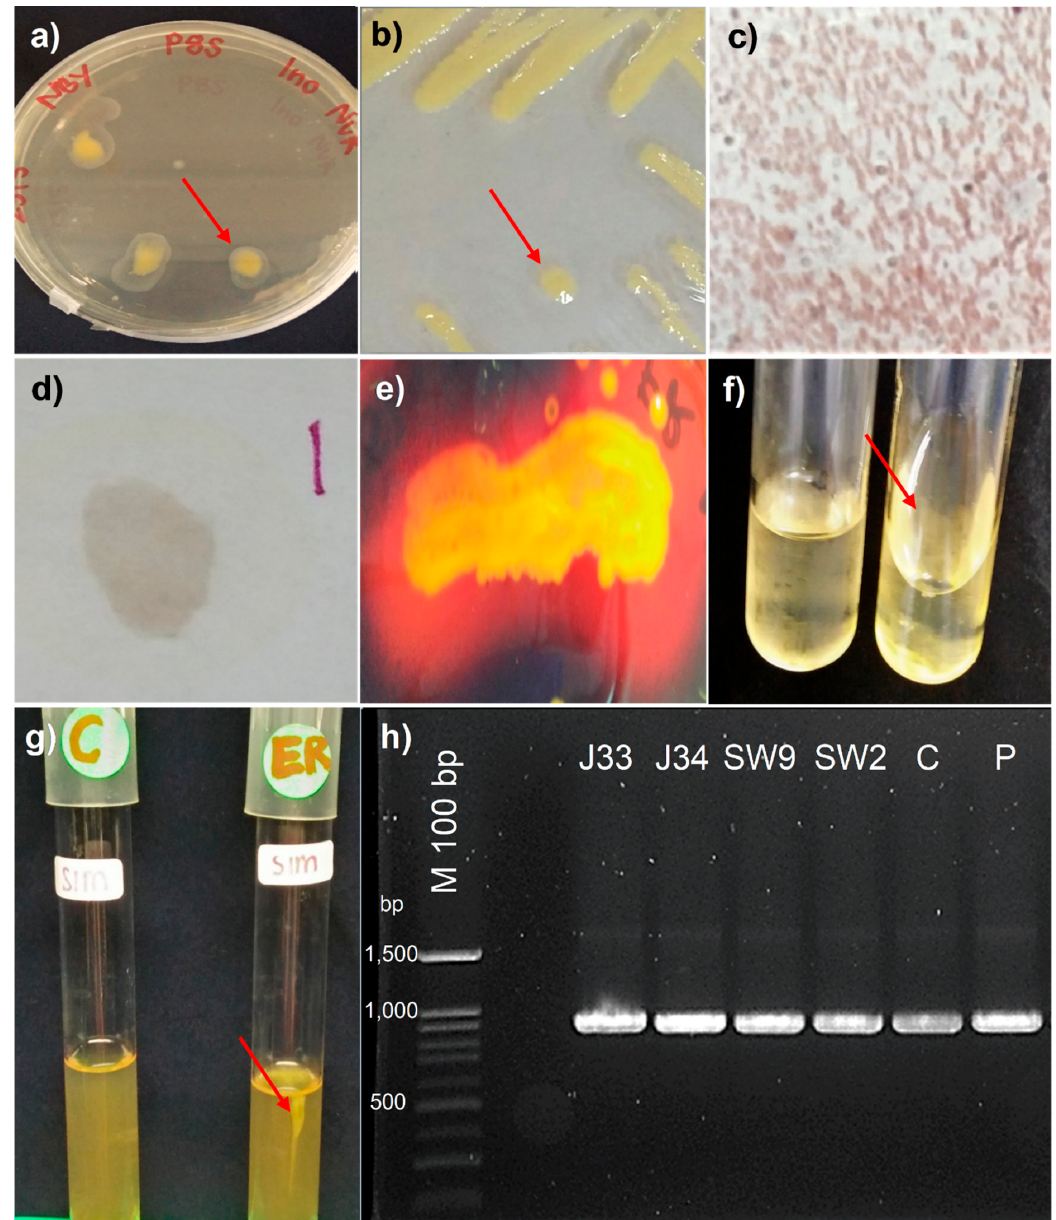
Figure 10. Koch’s postulates to identify the bacterial isolates from inoculated jackfruit varieties, sweetcorn, cucumber, and pineapple. ( a ) Colony morphology of bacterial isolate from inoculated pineapple (with isolate MS-8) via the spread-plate method on an NBY agar; ( b ) subcultured colonies’ morphology isolated from inoculated jackfruit variety J33 (with isolate MAR-D) on a King’s B agar medium; ( c ) Gram-staining of the bacterial isolate from inoculated jackfruit variety J34 (with isolate JEN-3); ( d ) Kovacs oxidase test of the bacterial isolate from inoculated cucumber (with isolate IPOH-I); ( e ) starch hydrolysis of the bacterial isolate from inoculated nine-week-old sweetcorn seedlings (with isolate MAR-F); ( f ) gelatin liquefaction of bacterial isolate from inoculated cucumber (with isolate IPOH-I), control (left); ( g ) indole production and motility test (SIM media) of the bacterial isolate from inoculated two-week-old sweetcorn seedlings (with isolate MAR-E), control (left); ( h ) gel electrophoresis showing representative bands of the PCR product of the bacterial isolate from inoculated fruits/seedlings (with isolate JEN-14) from the 16S-23S internally transcribed spacer (ITS) region. The size of the DNA ladder (M) used was 100bp (GeneDireX, Inc.) The amplification fragments were 920 bp (J33: jackfruit variety Tekam Yellow J33; J34: jackfruit variety Hong J34; SW9: nine-week-old sweetcorn seedlings; SW2: two-week-old sweetcorn seedlings; C: cucumber; P: pineapple).